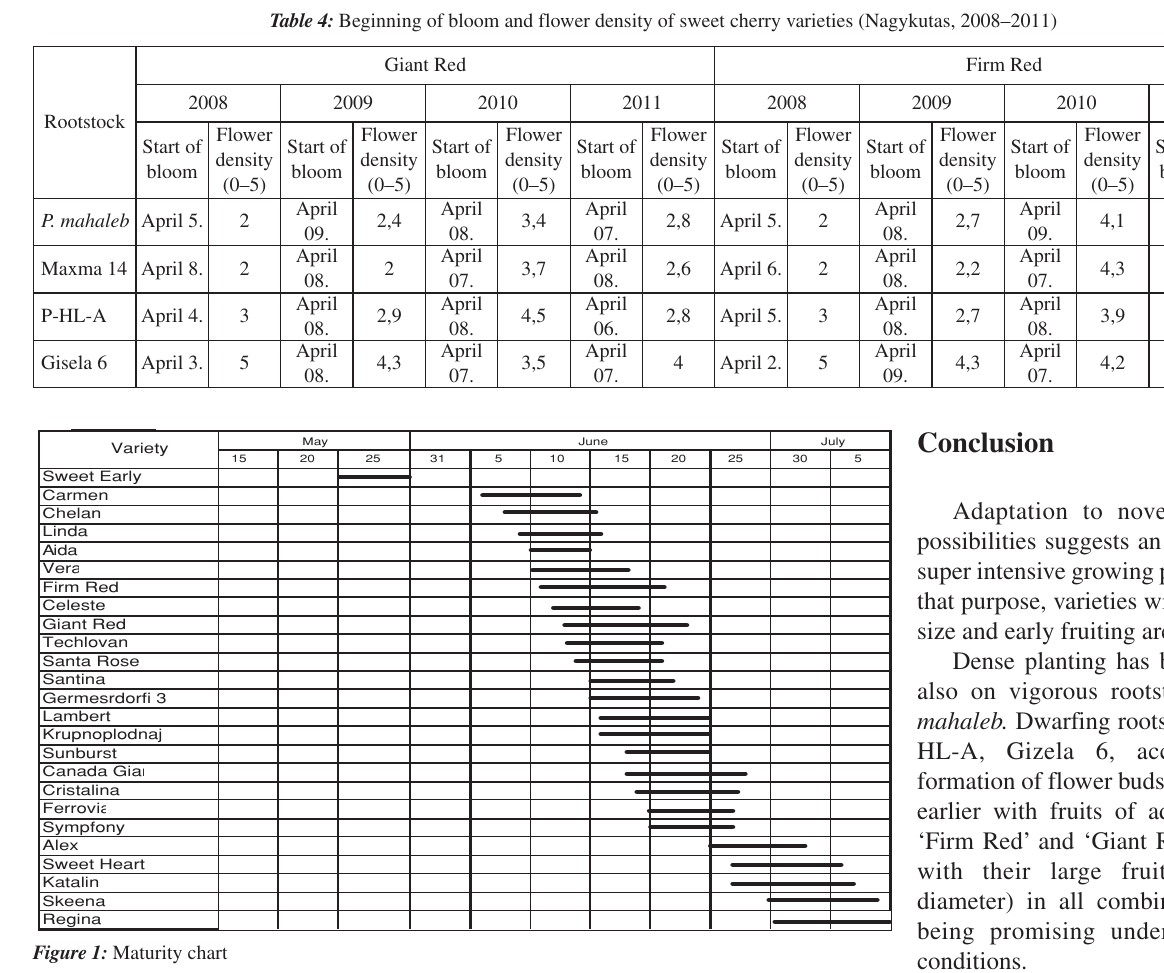
Table 5: Fruit quality of sweet cherry trees grown on different rootstocks (Nagykutas, 2008–2011) Giant Red Firm Red Rootstock